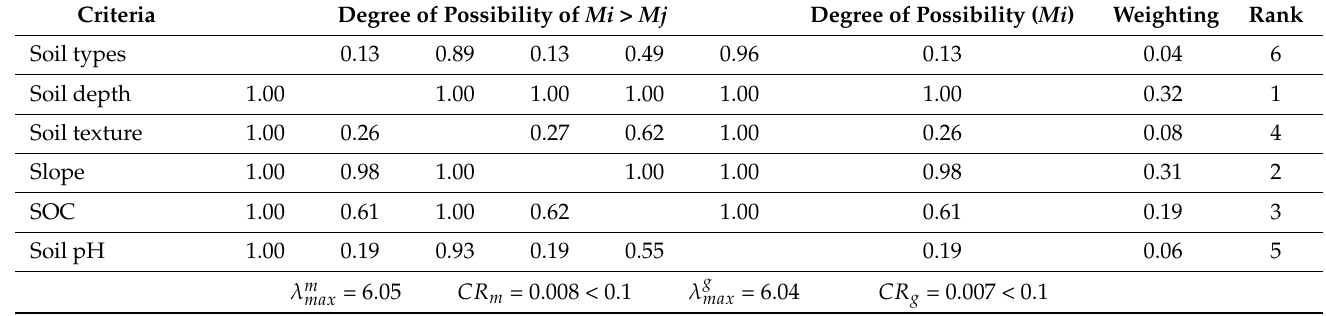
Table 8. The Degree of Possibility of Mi > Mj and criteria weighting by FAHP.